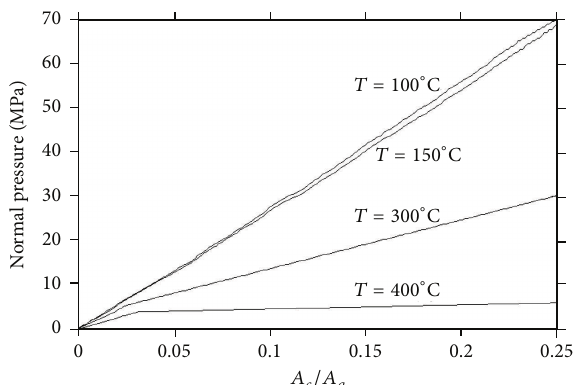
Figure 14: Normal pressure versus a -dimensional contact area.